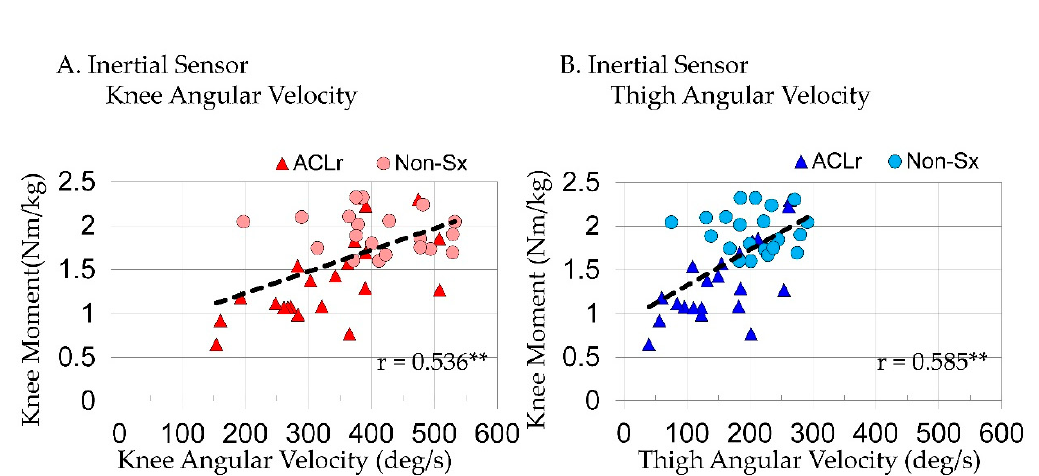
Figure 5. The relationship between peak knee extensor moments and ( A ) peak knee angular velocities and ( B ) peak thigh angular velocities measured with inertial sensors in the reconstructed (ACLr) and nonsurgical (Non-Sx) limb; ** p < 0.001.